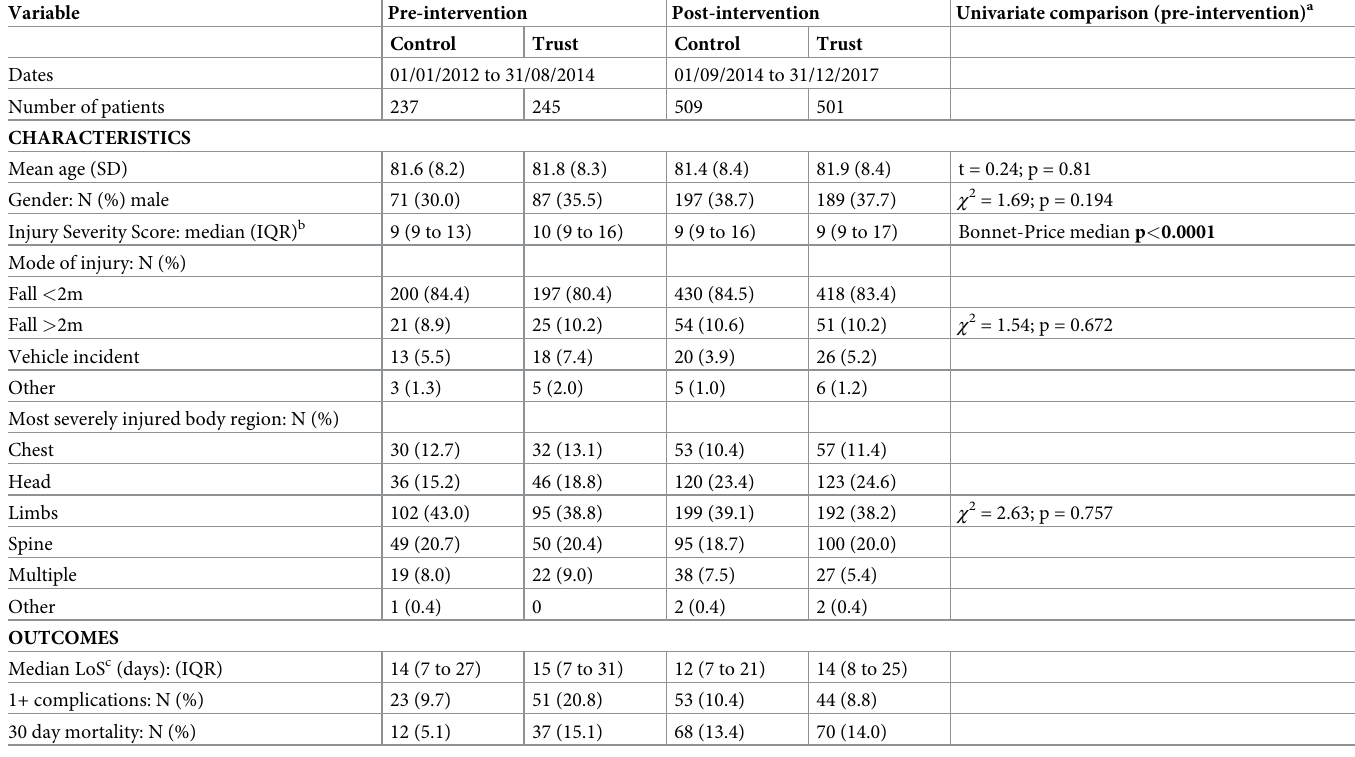
Table 1. Descriptive statistics by time period and group after propensity score matching.